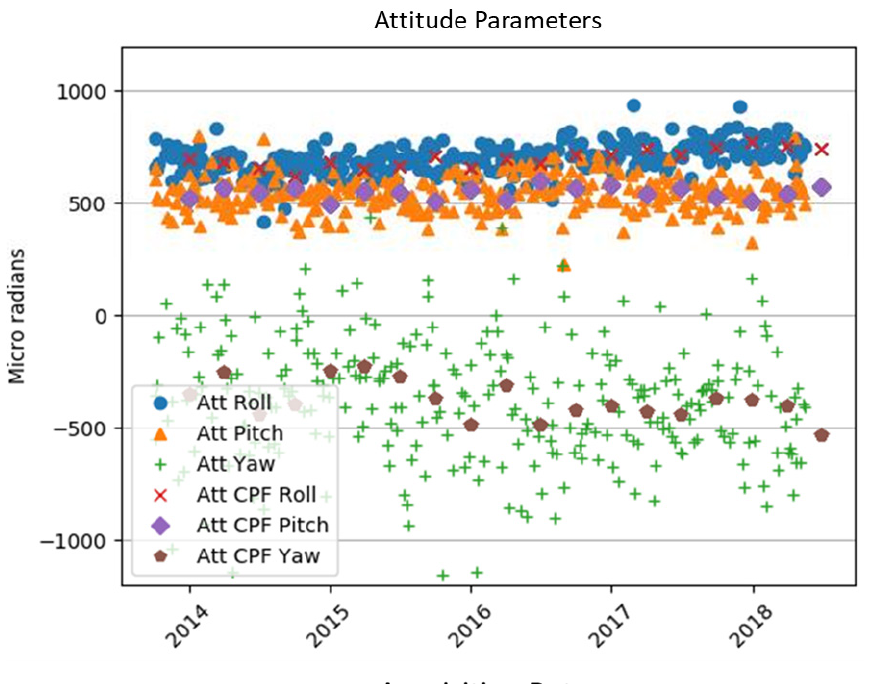
Figure 13. Plot of the attitude interior orientation parameters for the ETM+ sensor alignment. The yaw parameter has much more variability than that of the roll and pitch axis due to the difficulty measuring this parameter within the ETM+ instrument. The quarterly calibration parameter file (CPF) parameters calculated are displayed with a red x (roll), purple diamond (pitch), and crimson hexagon (yaw).